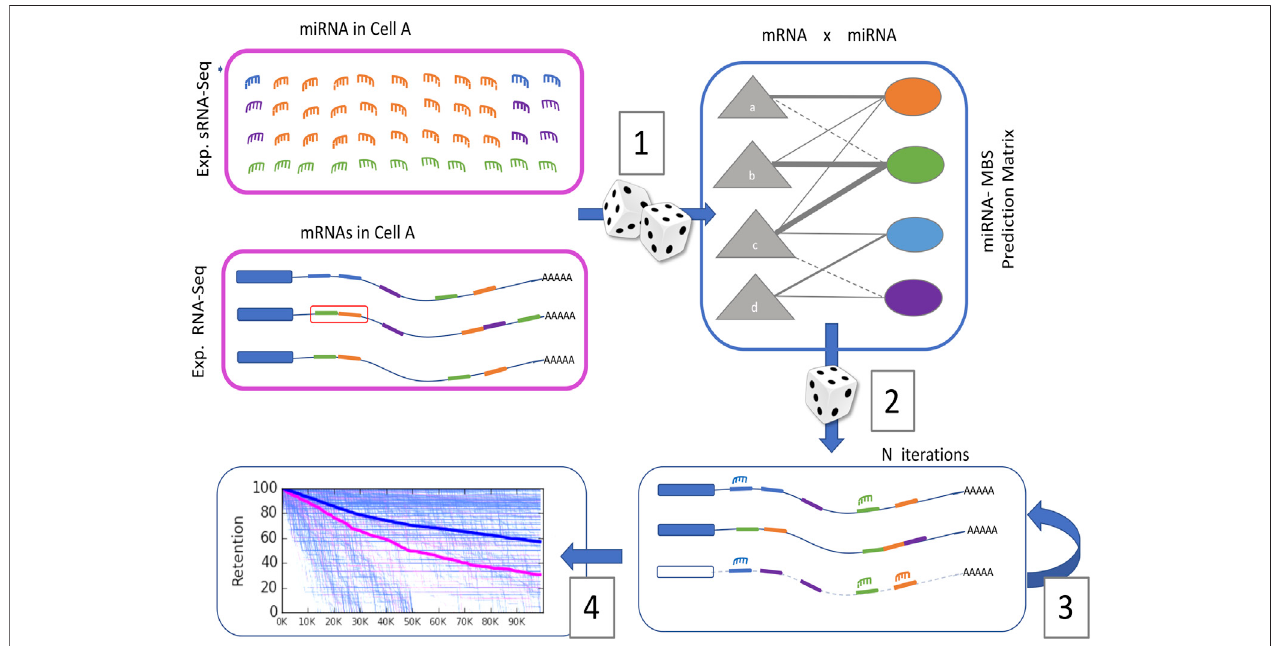
FIGURE 1 | Schematic procedure of the probabilistic nature of COMICS (see